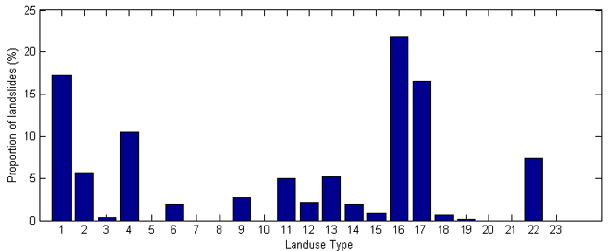
Fig.5. Distributionoflandslidesinthe23landuselandcoverclasseslistedinTable 2. Fig. 5. Distribution of landslides in the 23 land-use land cover classes listed in Table 2.